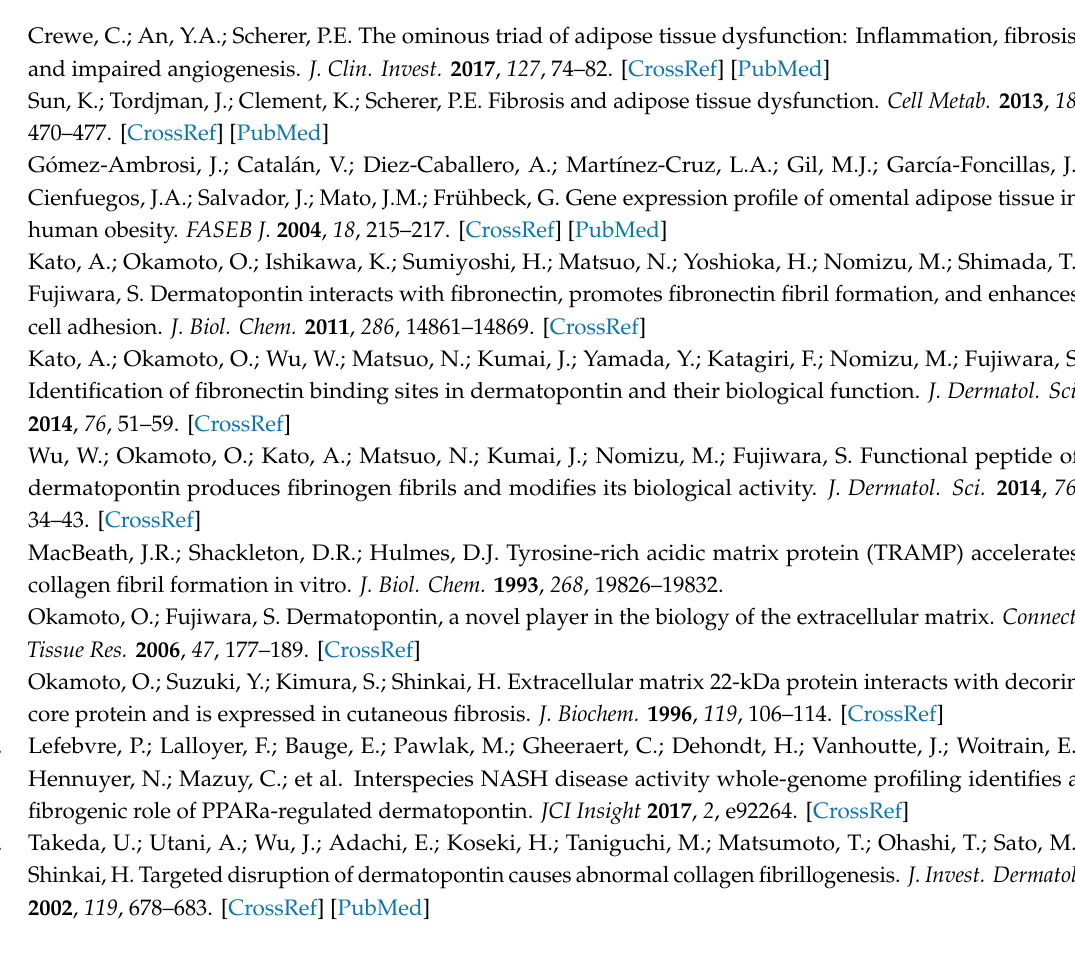
Table S1: Sequences of the primers and TaqMan ®